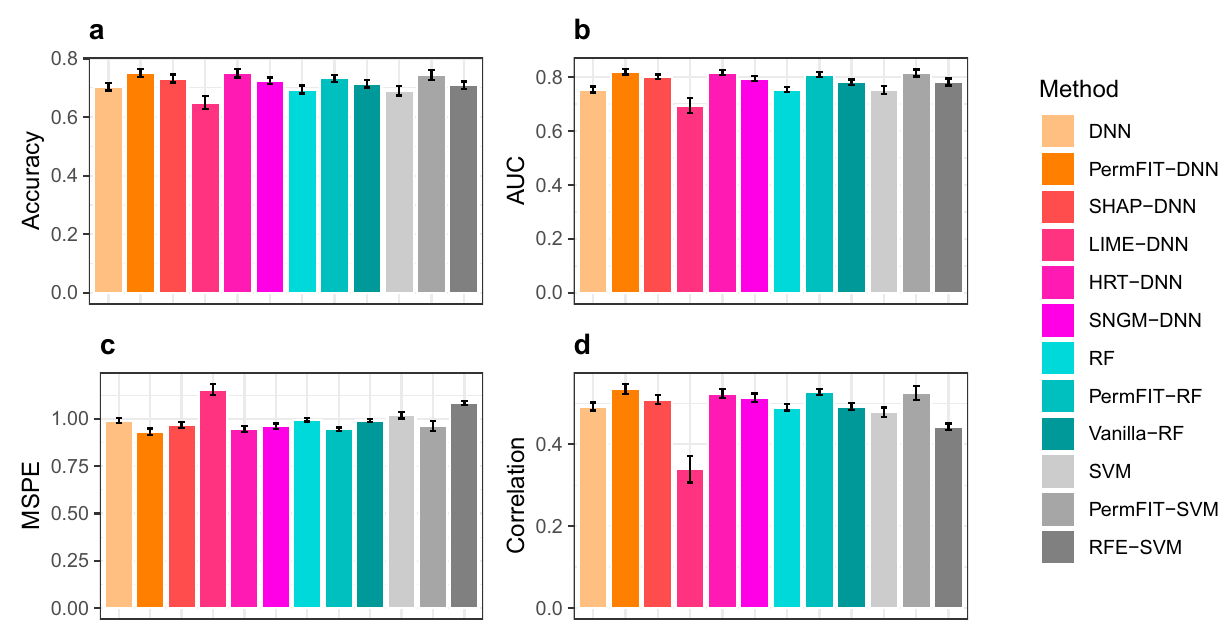
Fig. 3 Model performance improvement from feature selection. a , b Fivefold cross-validated prediction accuracy and AUC for TCGA kidney cancer data. c , d Fivefold cross-validated MSPE and Pearson correlation (between true outcome and prediction) for HITChip Atlas data. Fivefold cross-validation evaluation is randomly repeated for 100 times. Data are presented as mean values± s.d. Source data are provided as a Source Data fi